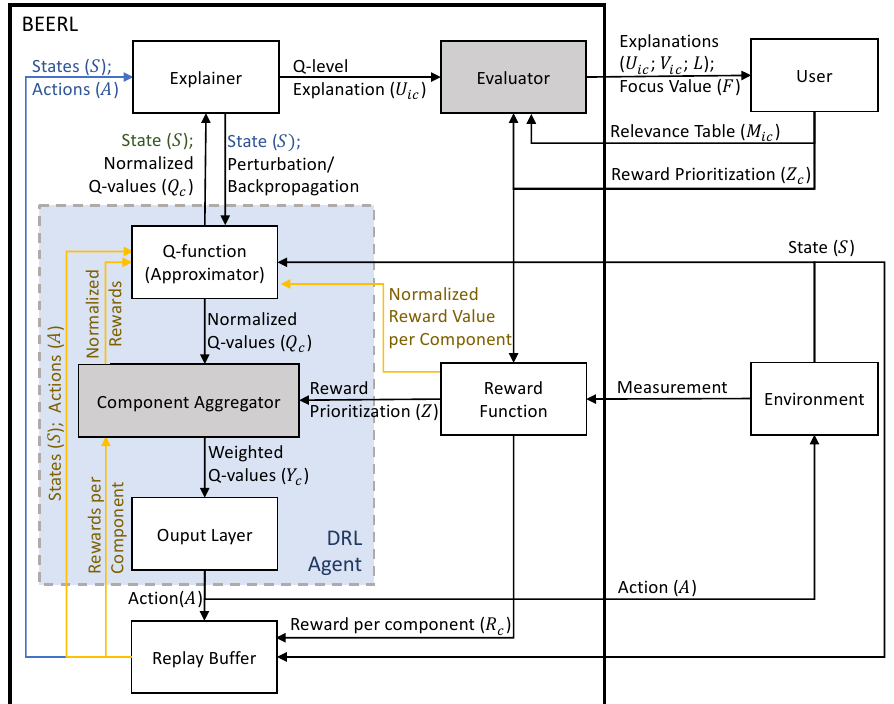
Figure 1. Main elements of BEERL and interactions among them. The gray boxes present the newly proposed elements in this work. The blue line is executed for generating a global explanation while the green text (state information) is passed when generating local explanation. The yellow lines are only executed during training process i.e., updating Q-function